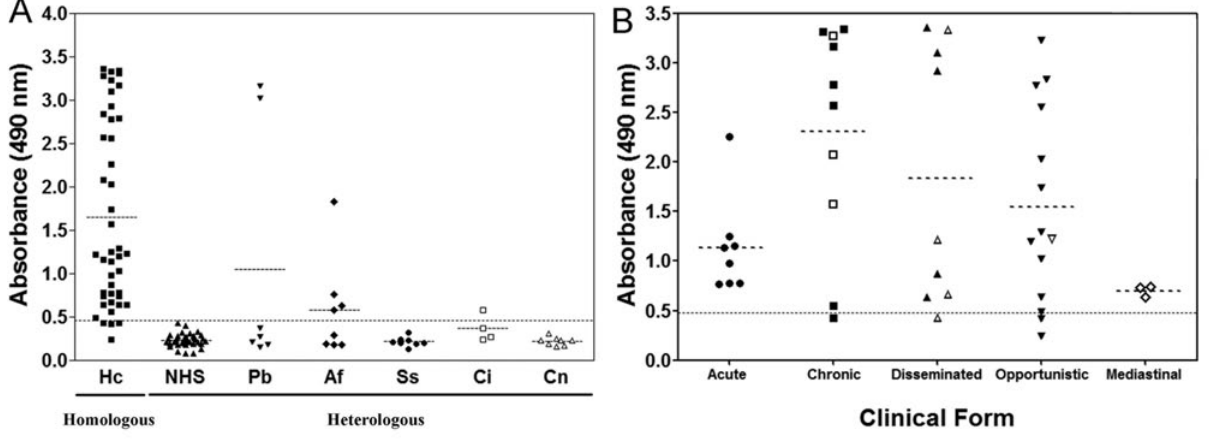
Figure 3. Graph of the comparison of immu- nodiffusion and ELISA. The X axis shows the titer of the samples tested by immunodiffusion (log- arithmic scale) and Y axis shows the absorbance. Dashed straight line represents the best fit line for lin- ear regression and both curves above and below show the limits of the confidence intervals. Each symbol represents a single sample tested by both methods and the values were plotted on the graph. Correl- ation was found between the averages of ELISA absorbances from samples having the same ID titer.